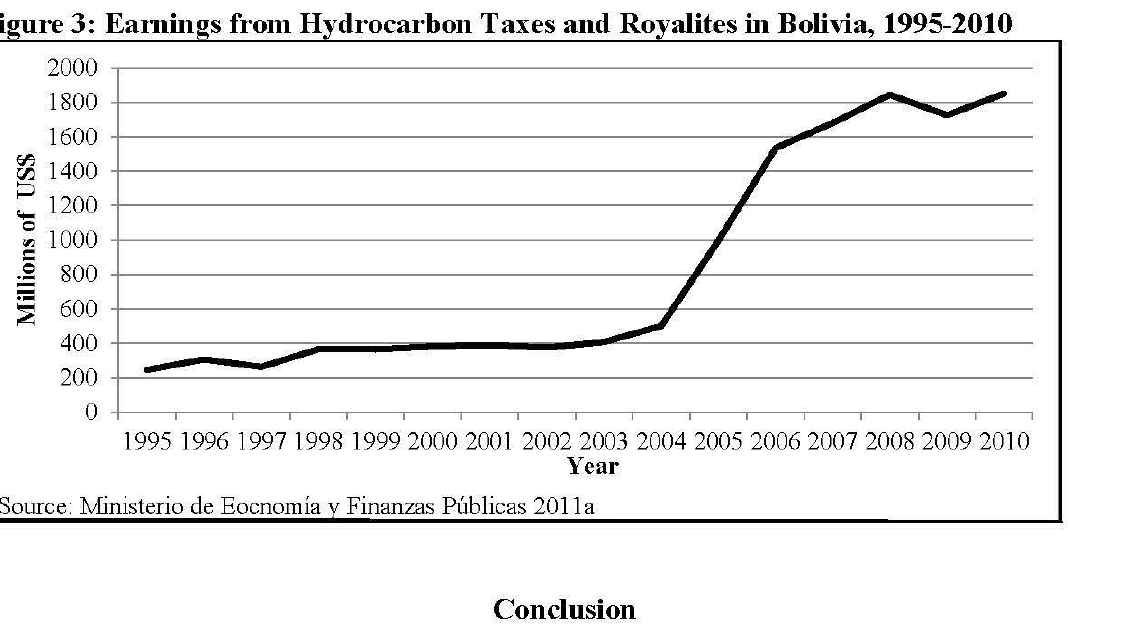
Figure 3: Earnings from Hydrocarbon Taxes and Royalites in Bolivia,